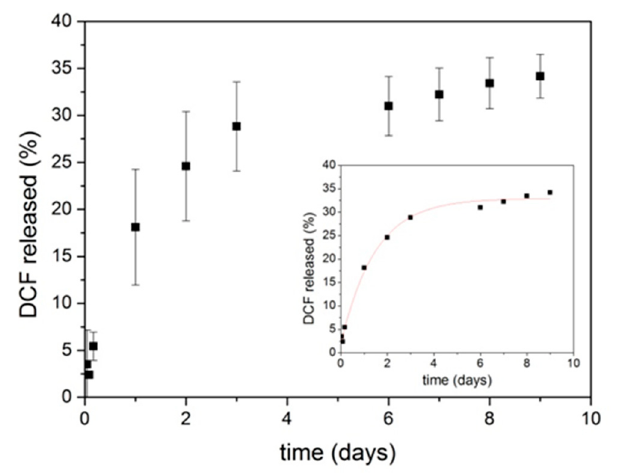
Figure 5. Release profile of DCF from PolyCD@Ada-Rhod/DCF nanoassemblies in PBS (pH = 7.4) at 37 °C (Spectra/Por® dialysis bags, MWCO 3.5 kDa). Data are reported as the mean three independent experiments ± SD. In the inset experimental data are best-fitted first order kinetic model.